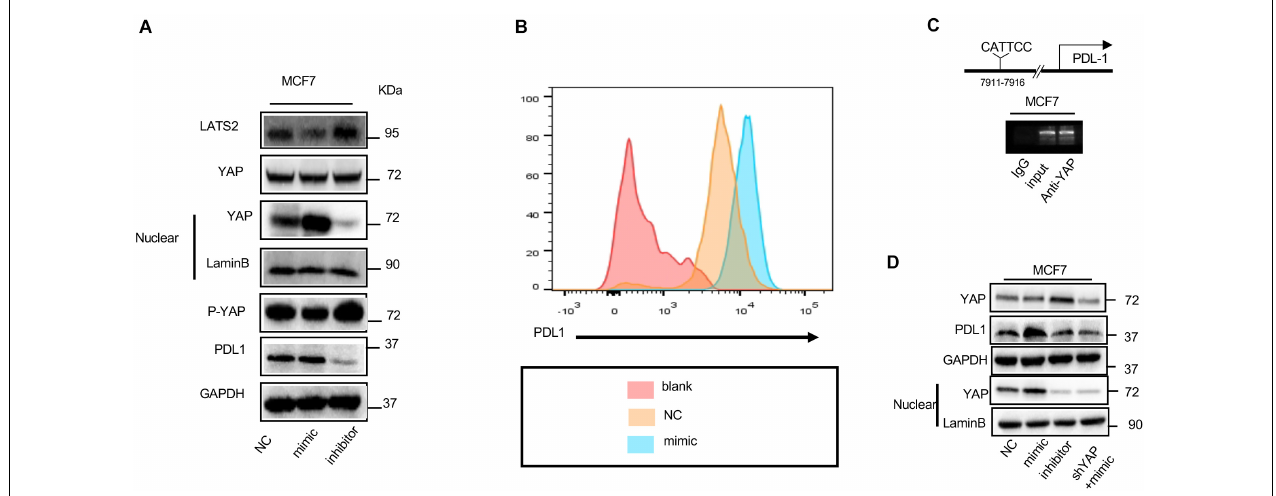
FIGURE 4 | miR-92 promotes PD-L1 transcription activity by enhancing the nuclear translocation of YAP1. (A) Western blot shows the YAP1, LATS2, and PD-L1 expression in MCF7 which was transfected with the miR-92 mimic or inhibitor. (B) Flow-cytometry analysis for PD-L1 expression in MCF7 which was transfected with NC or miR-92. Blank is an unstained group indicating negative fluorescence intensity. (C) ChIP assay was performed with MCF7 which is shown by gel bands of the RT-PCR products with 30 cycle. (D) Western blot shows the YAP1 and PD-L1 expression in MCF7 which was transfected with the miR-92 mimic or inhibitor or/and shRNA targeting